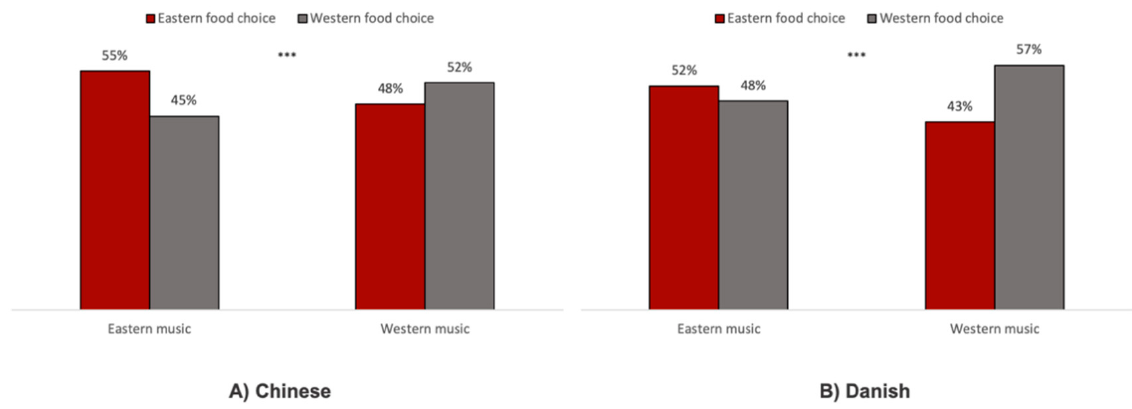
Figure 3. Choice distributions of ( A ) Chinese participants and ( B ) Danish participants, based on the chi-square tests of independence. *** indicates p < 0.001.